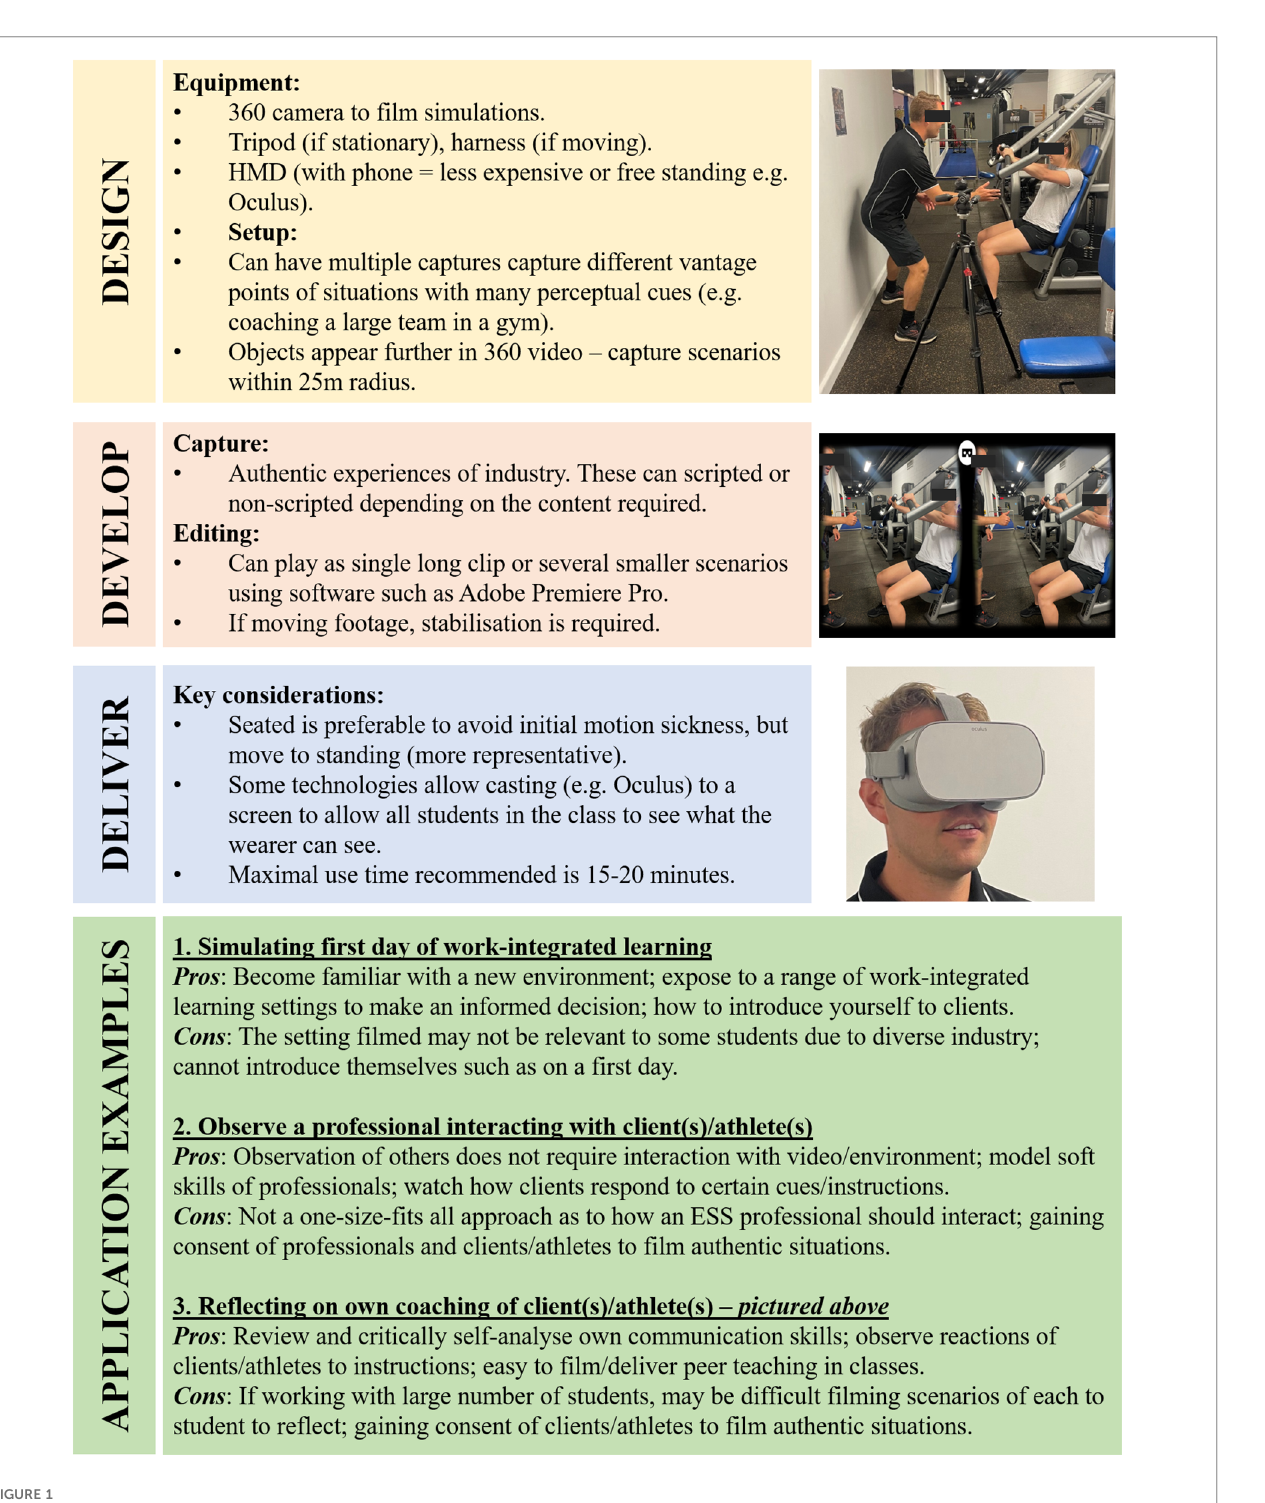
FIGURE 1 An overview of how to design, develop and deliver 360°VR in ESS higher education, with examples of